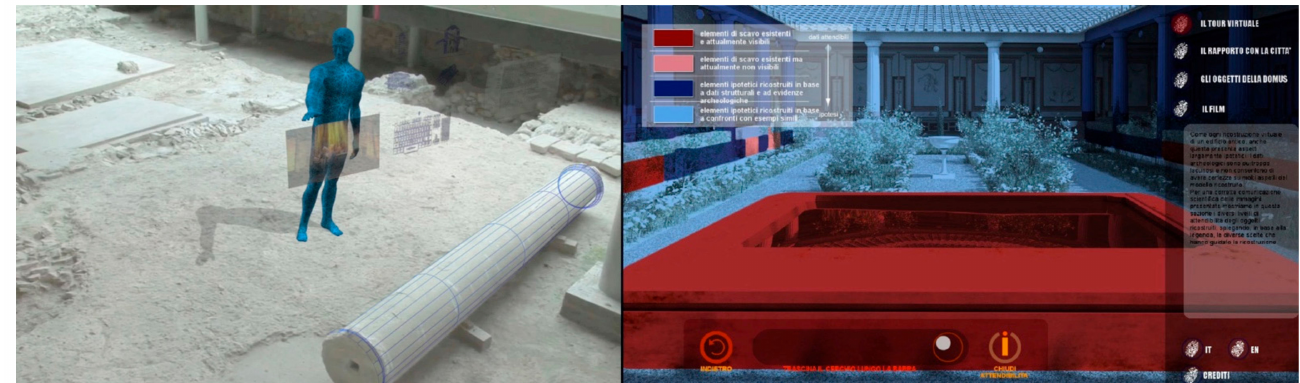
Figure 4. Teramo virtual city project, Sant’Anna archaeological site. ( Left ) the virtual architect “Virtuvius” explains to the public how complex a process of virtual reconstruction is, dealing with uncertainty. ( Right ) Roman domus in false colors, declaring the reliability levels. CNR, Institute of Technologies Applied to The Cultural Heritage,